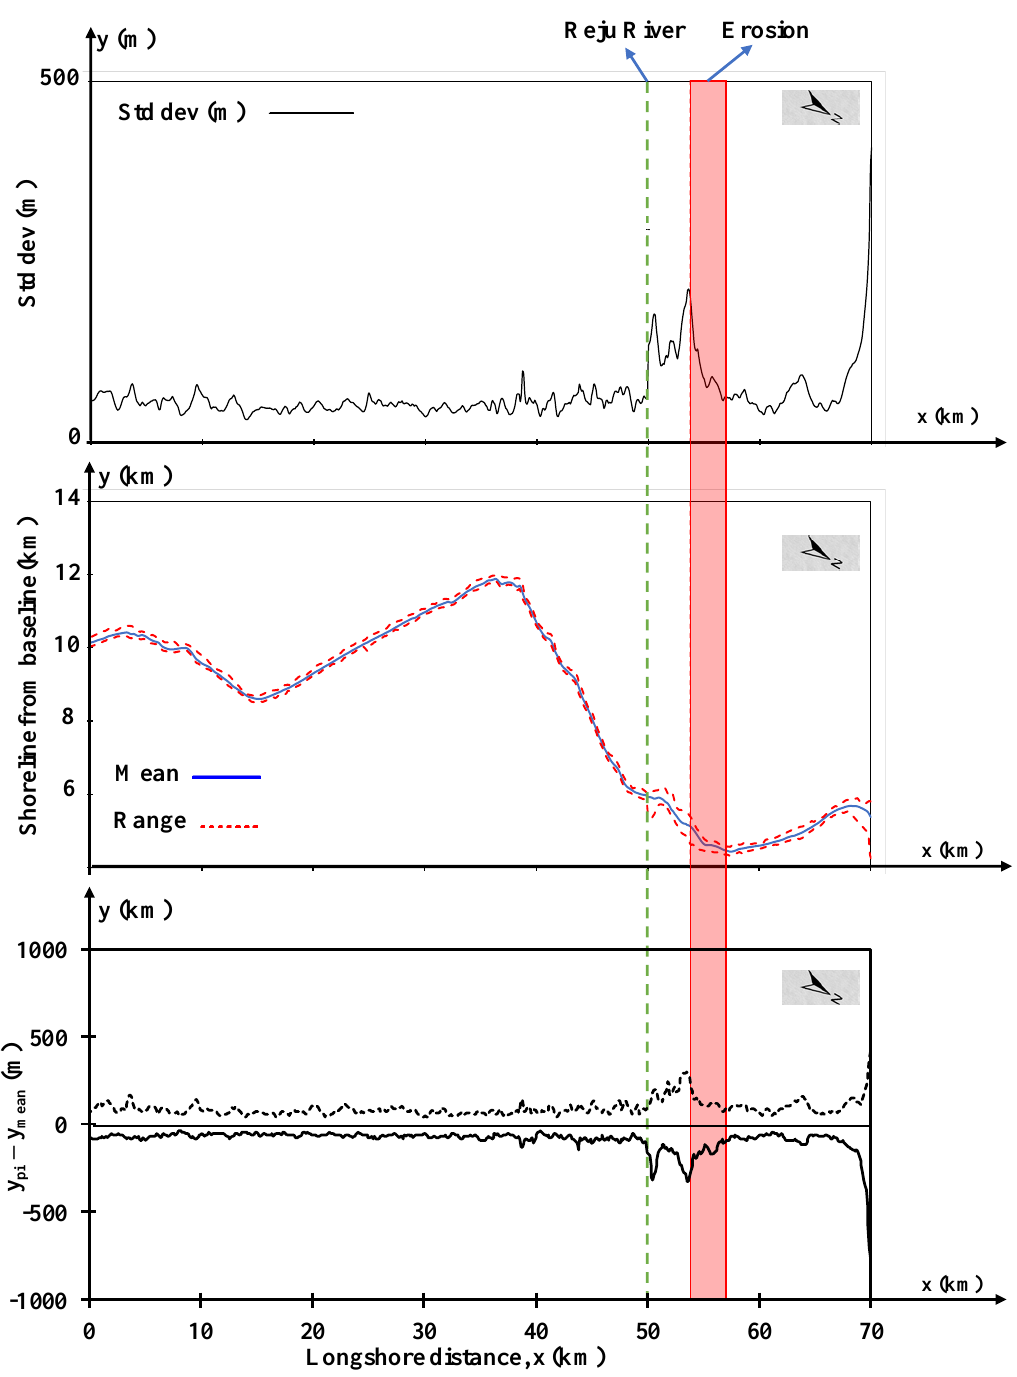
Figure 6. Mean shore position with range and standard deviation. Alongshore variation of the 10th (solid lines) and 90th (dashed lines) percentiles with respect to the mean shoreline (bottom panel). Green dashed line indicates the Reju River mouth.